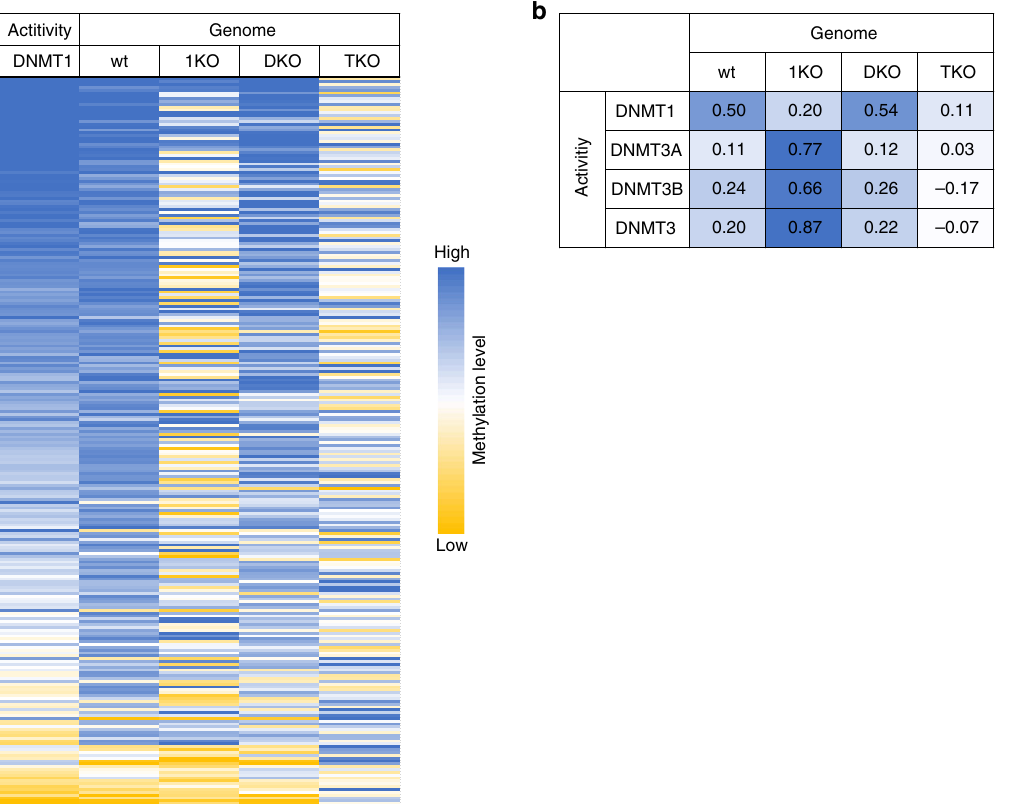
Fig. 7 Comparison of DNMT1 fl anking sequence preferences with genomic DNA methylation. a Correlation of the DNMT1 NNCGNN fl anking sequence preferences (Activity DNMT1) with average genome-wide methylation levels of CpG sites in NNCGNN fl anking contexts (Genome). Genomic methylation data were determined by whole genome bisul fi te analysis in wild type mouse ES cells (wt), DNMT1 knock-out ES cells (1KO), DNMT3A/DNMT3B double knock-out ES cells (DKO) and DNMT1/DNMT3A/DNMT3B triple knock-out ES cells (TKO) 42 . The image shows the average methylation levels of individual NNCGNN sites as heatmaps. b Pearson correlation factors of the NNCGNN genome methylation patterns (Genome) of the different mouse ES cell lines with the fl anking sequence preferences (Activity) of DNMT1, DNMT3A and DNMT3B (Fig. 3b) and an average of DNMT3A and DNMT3B (DNMT3). DNMT3A and 3B fl anking preferences were taken from Gao et al. 25